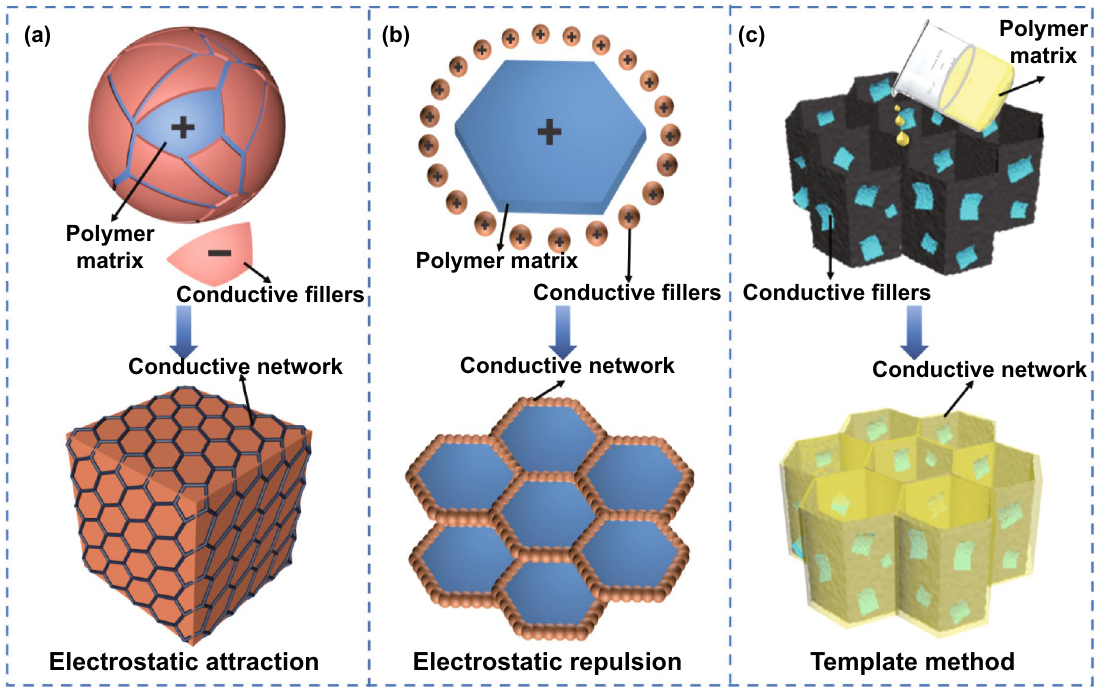
Fig. 1 Schematic illustration of constructing efficient conductive networks by a electrostatic attraction, b electrostatic repulsion and c template